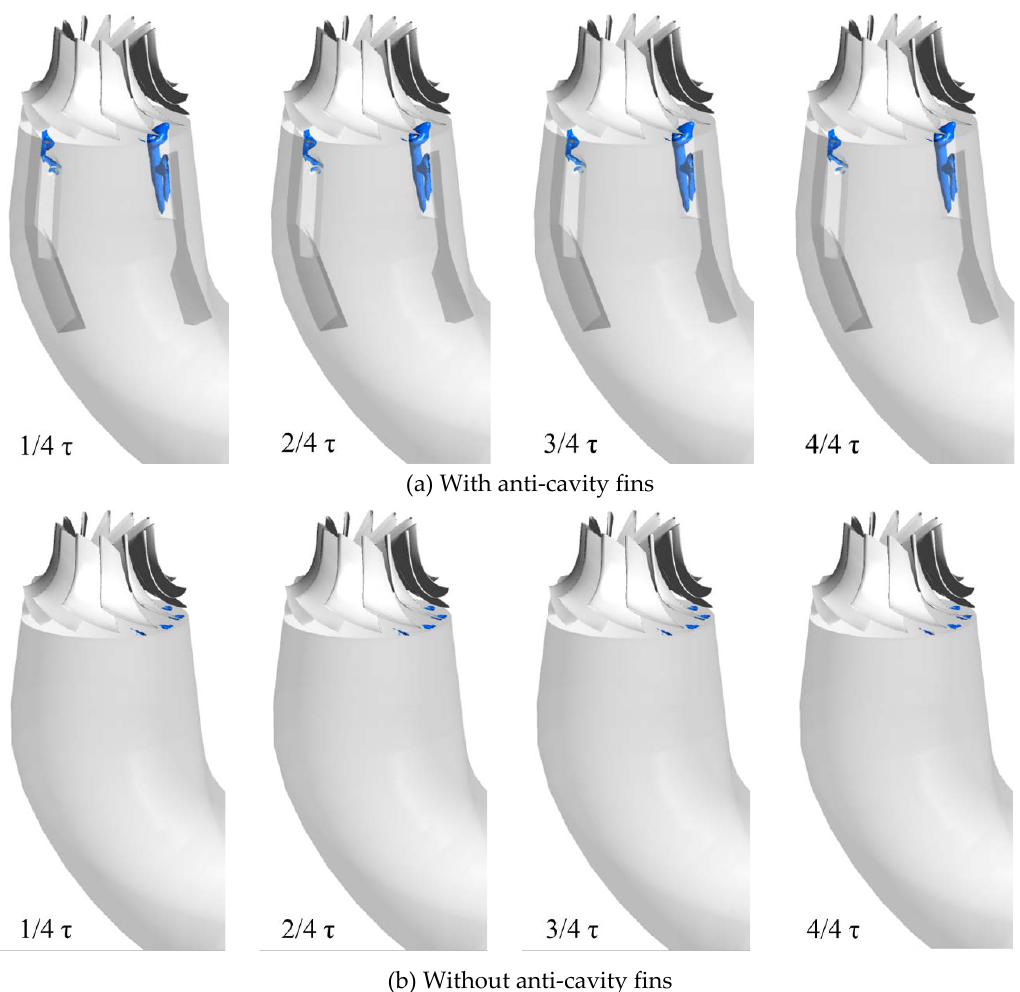
Figure 7. Iso-surface distributions of pressure in the DT during one runner revolution at a GV of 22°: (a) with anti-cavity fins; and (b) without anti-cavity fins.